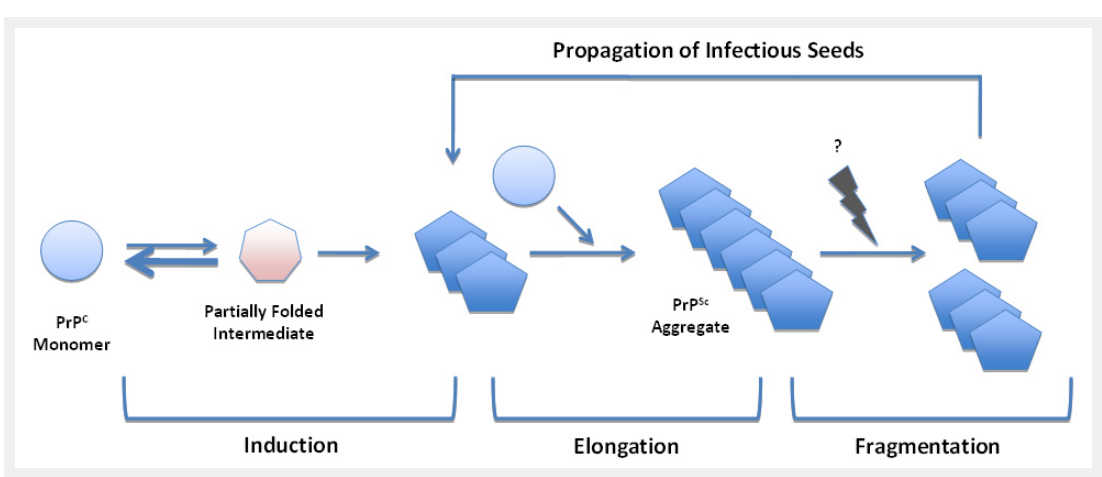
Schematic model of seeded polymerisation, which involves the interaction between a prion seed with PrP C . Partial unfolding of PrP C may promote induction and propagation of PrP C to PrP Sc . It is unknown how prion aggregates or fibrils are fragmented into reactive infectious seeds.